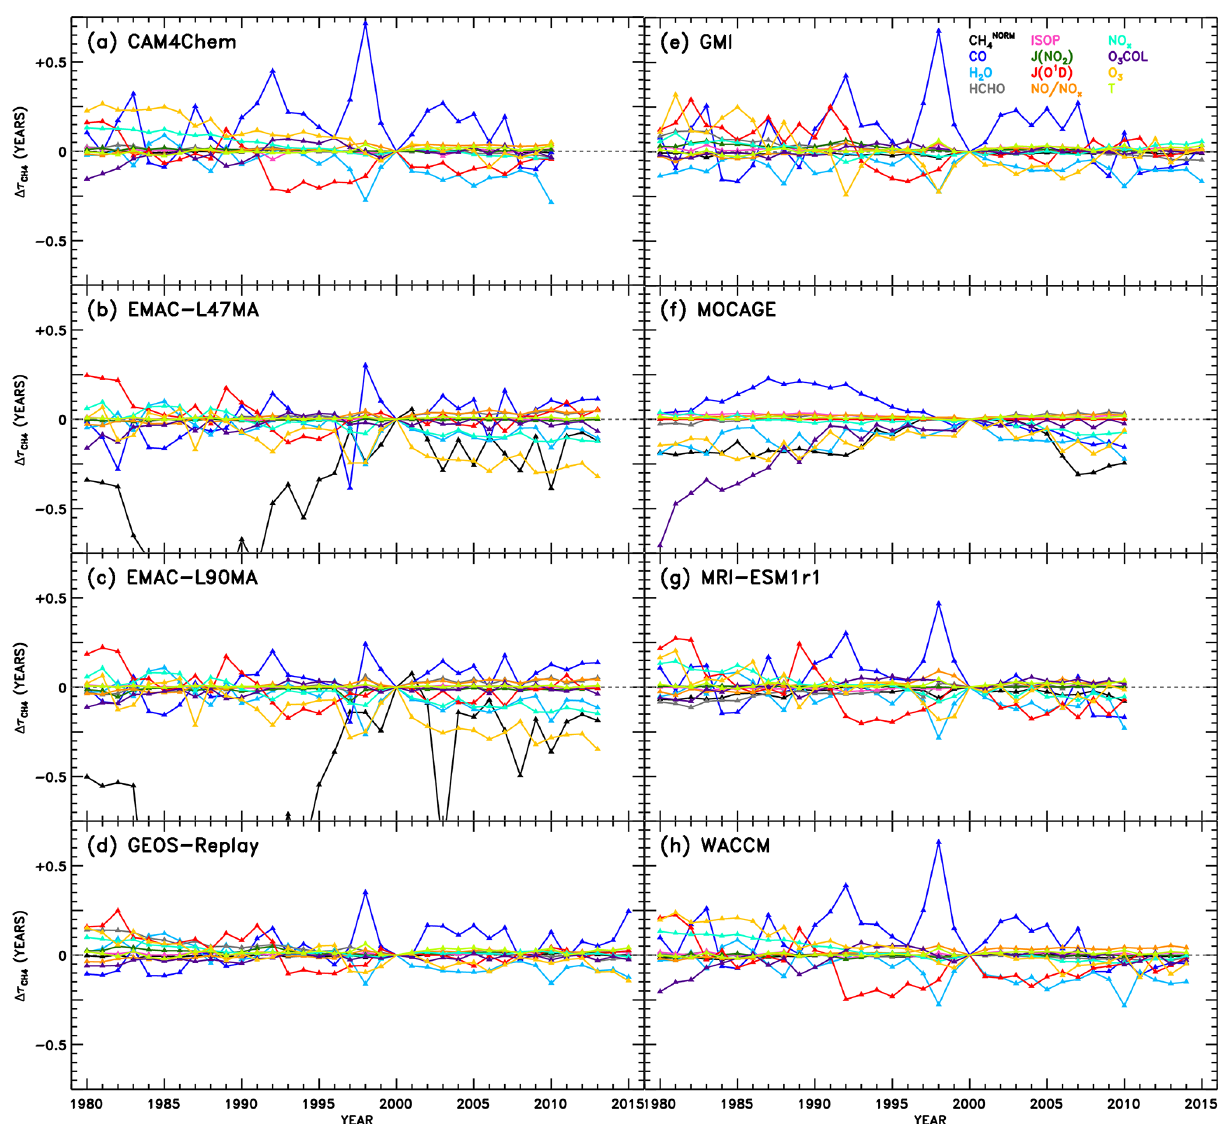
Figure 7. Attributions of changes in CH 4 lifetime relative to the year 2000 of the REF-C1SD simulations. Within the NN of a given model, use of individual inputs (indicated by colour) from years other than 2000 result in a change and OH and subsequent CH 4 lifetime, shown here. The variations attributable to CH 4 are labelled “CH NORM ” to designate the use of normalized CH 4 fields as inputs to the NNs, as 4 described in Sects. 3.1 and 4.3. As a result, OH changes due to CH NORM represent impacts of changes in how CH 4 is distributed within the 4 troposphere, rather than how CH 4 concentrations are changing over